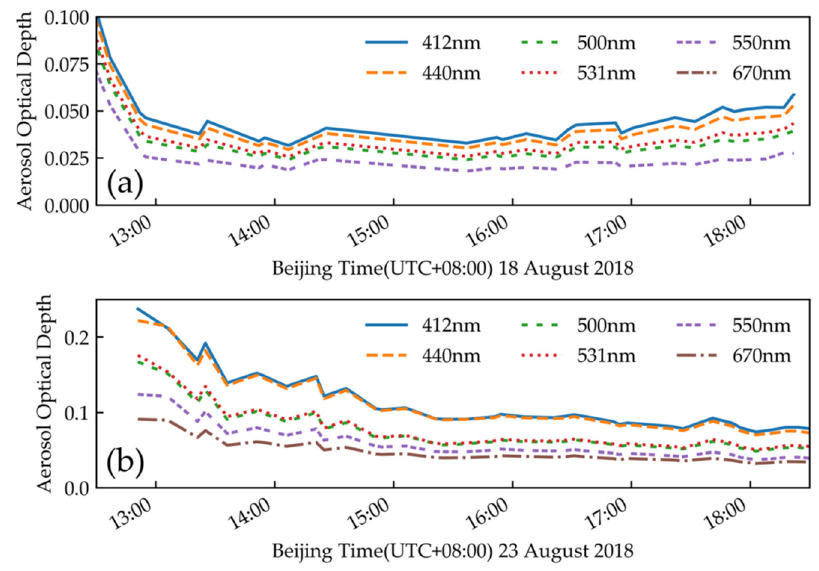
Figure 7. AOD ( a ) at 14:38 (UTC + 08:00), 18 August 2018; ( b ) at 14:43 (UTC + 08:00), 23 August 2018.